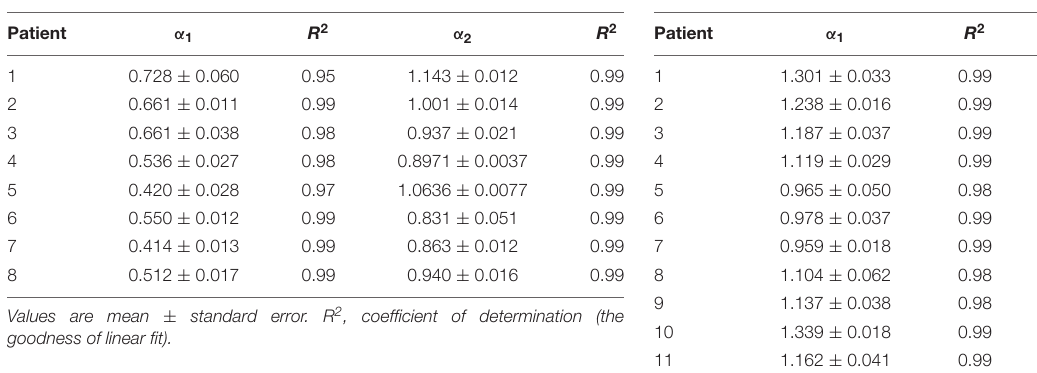
TABLE 4 | Estimated values of short-term ( α 1 ) and long-term ( α 2 ) scaling exponents in the third cluster of heart failure patients.